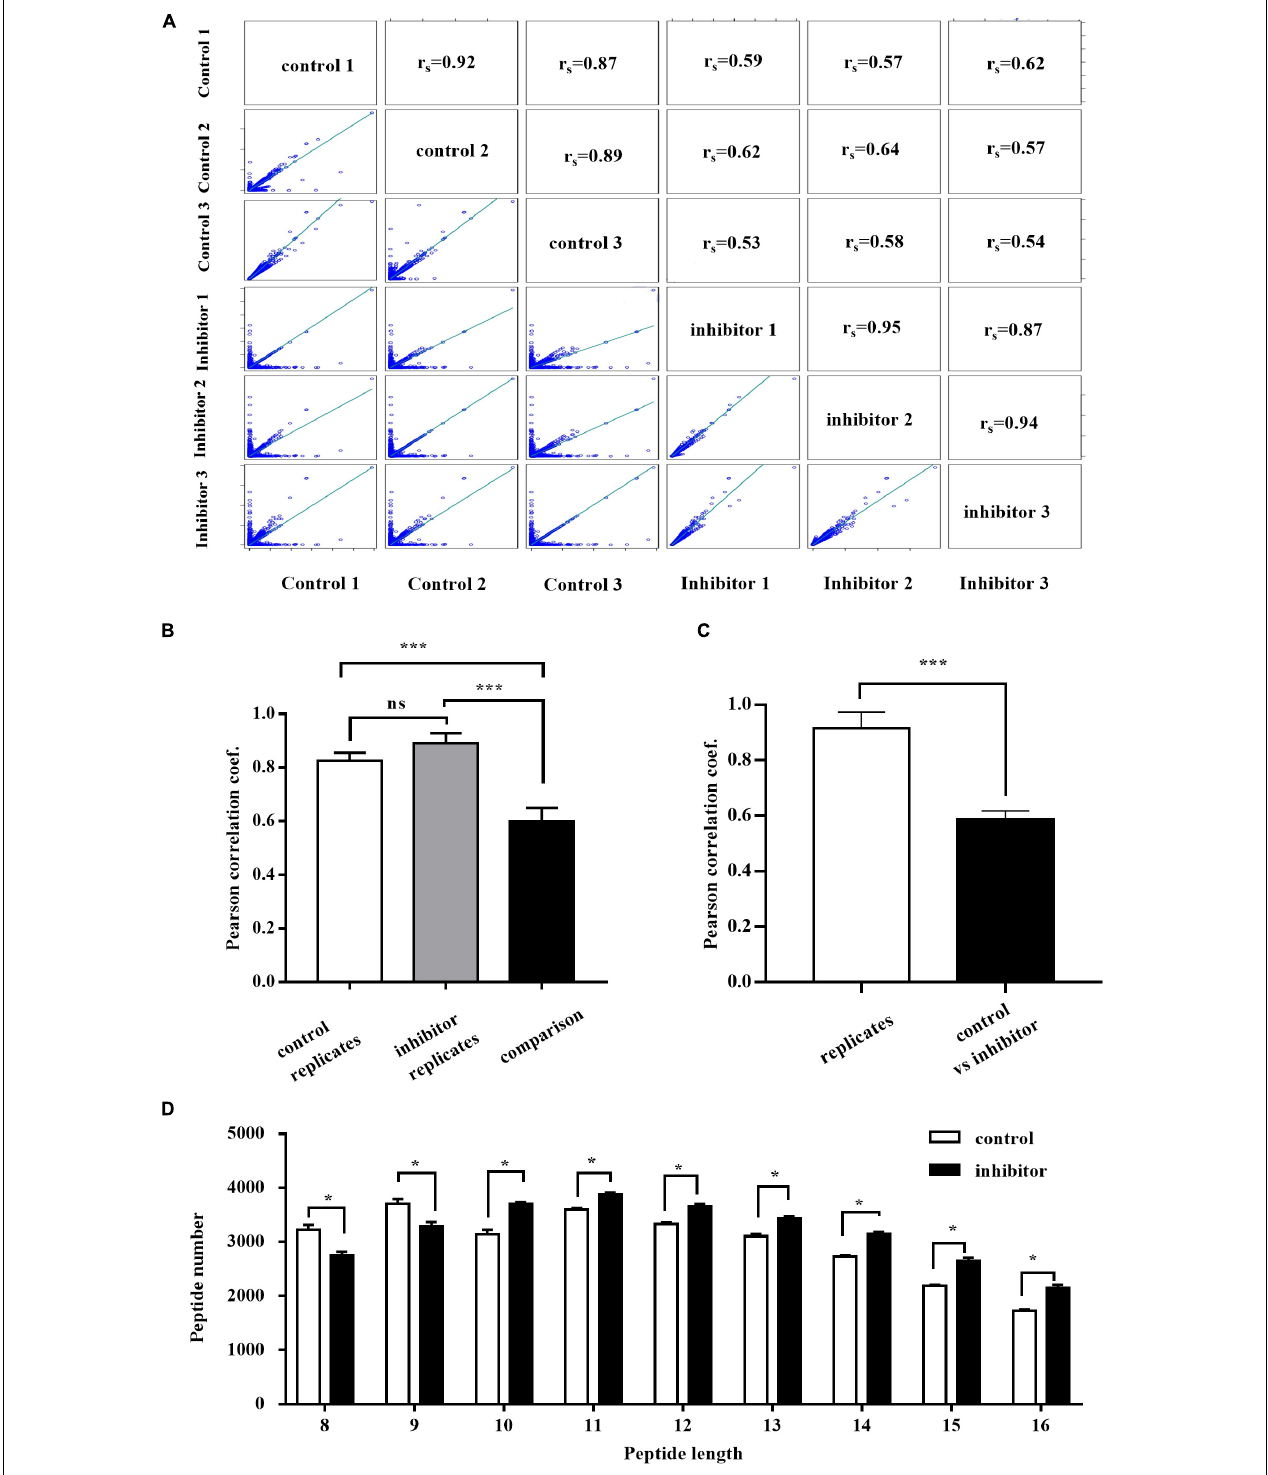
FIGURE 3 | ERAP1-IN-1 treatment affects (8–16)-mers peptides distribution in HepG2.2.15 cells. (A) Peptide intensity correlations between different experiments and replicates. The calculated Pearson coefficient is indicated in each panel. (B) Average Pearson coefficient of correlations between control replicates, inhibitor replicates, and control vs. inhibitor experiments. (C) Average Pearson coefficient of correlations between replicates of the same condition and control vs. inhibitor. (D) The peptide length distribution of 8–16 residues in the control and inhibitor groups detected by LC/LC-MS. LFQ, label-free quantification. * P < 0.05; *** P <